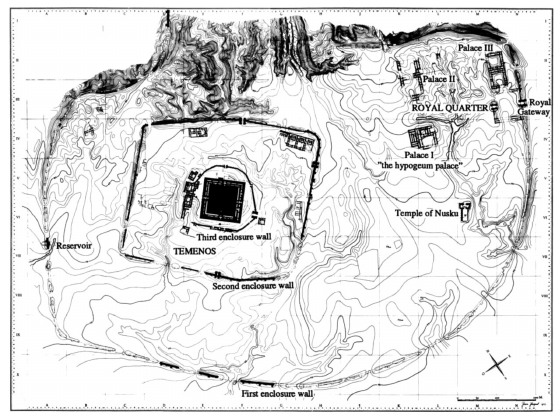
Figure 4. Topographic map of Ziggurat Chogha Zanbil (from Ghirshman, 1966).